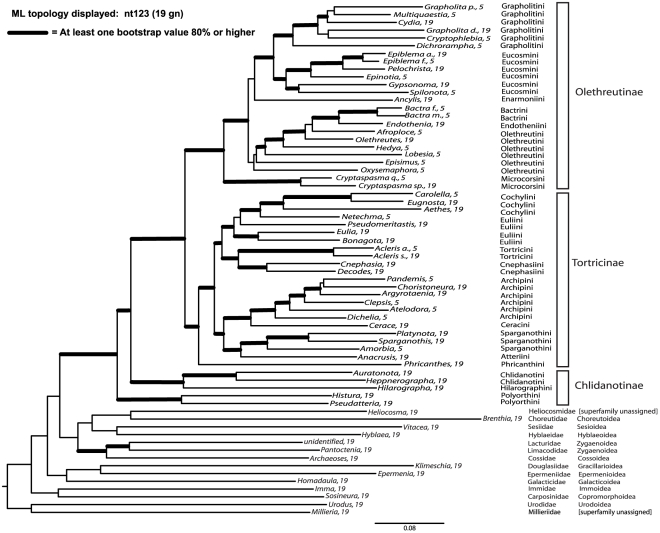
Phylogram presentation of best maximum likelihood tree obtained from 1000 GARLI searches.Model used was a GTR+gamma+I model for all nucleotides (unpartitioned). Thickened branches are supported by ≥80% bootstrap in at least one analysis (see Fig. 3).